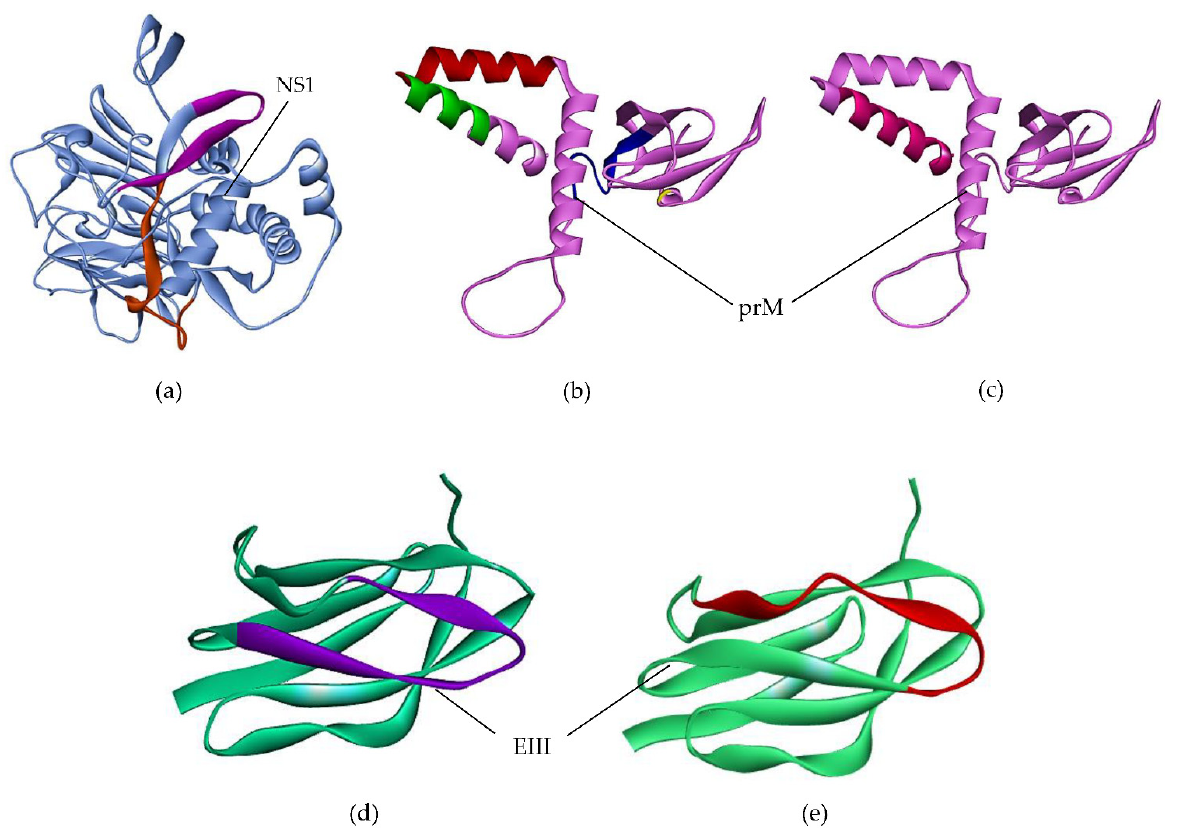
Figure 4. Illustration of Location of epitopes on 3D structures of candidate vaccine proteins. ( a ) Selected B-cell epitopes on NS1 protein, PETAECPNTNRAWNSL (red) and YGFGVFTTNIWLKLKE (purple); ( b ) Selected B-cell epitopes on prM protein, YGTCTATGEHRREKRS (blue), AYTIGTTYFQRVLIFI (red), GFTIMAAILAYTIGTT (green); and ( c ) RVLIFILLTAVAPSMT (pink); ( d ) Selected B-cell epitopes on EIII protein, GRLITVNPIVTEKDSP (purple) and ( e ) NPIVTEKDSPVNIEAE (red).